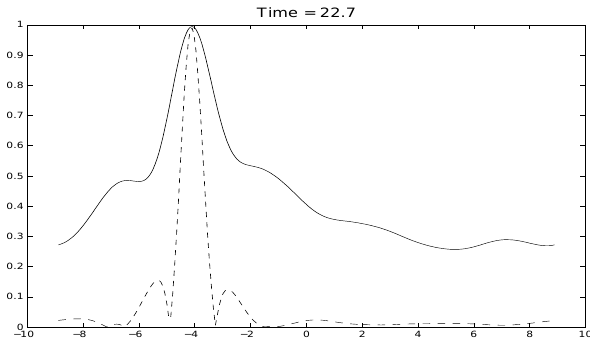
(solid line) and of the u ( x,t ∗ ) | |